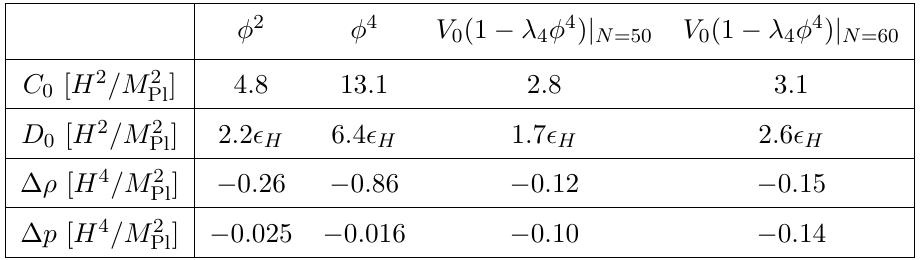
Table 1 . Estimates of the tensor and scalar correlators ( C 0 resp. D 0 ) as well as the Friedmann corrections in eq. (4.19) for two monomial potentials and the quartic hilltop potential of eq. (4.20). For the quartic hilltop potential the parameter λ 4 is estimated given a selected value of the number of e -foldings N